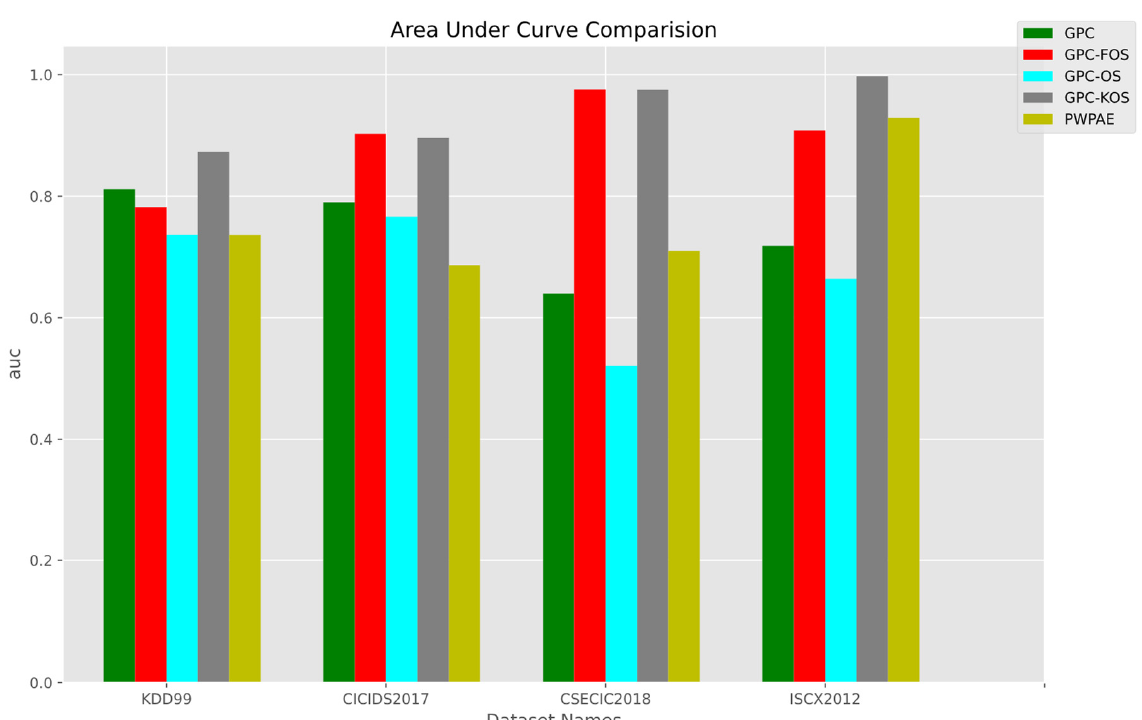
Figure 14. F1-score of the incremental GPC (OS, FOS, KOS) variants and benchmarks (GPC, PWPAE) for real-world data.